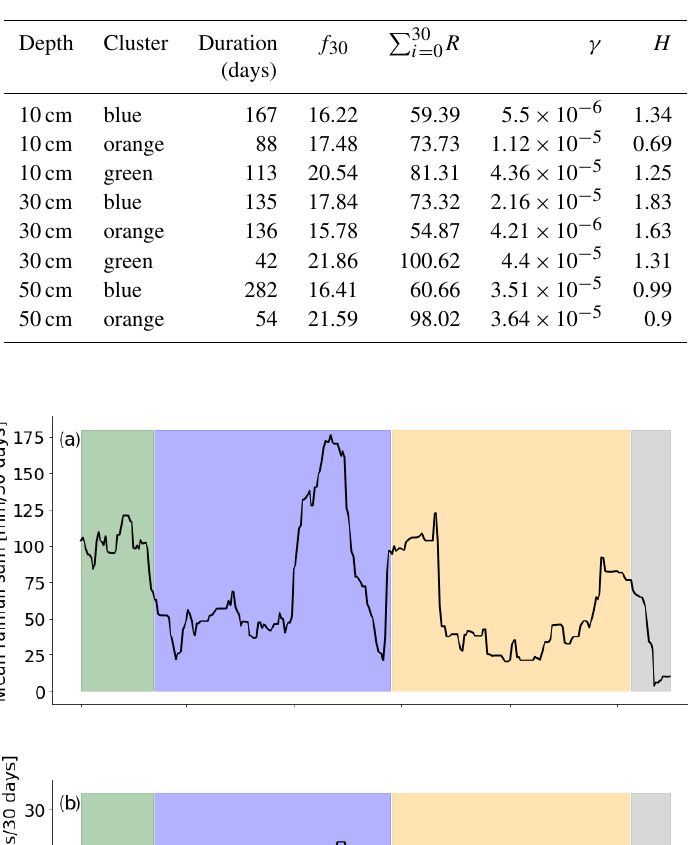
Table B1. Quantitative results summary. For each depth and cluster of 2016 different cluster characteristics were calculated. The duration of each cluster is given in the third column. To compare rainfall forcing with the emergence of clusters, the rainfall characteristics were based on the same moving window as the clusters. The mean rainfall frequency f 30 within each window is given in the fourth column. The mean R in the fifth column. To assess the variability of dispersion functions within each cluster, different 30d sum over the whole cluster (cid:80) 30 i = 0 measures are given. γ is the dispersion, as calculated in Eq. (2). This describes the dispersion of dispersion functions within one cluster. H is the entropy of the distribution of all cluster members within each cluster. Both measures are calculated for the distribution of each distance lag class individually.